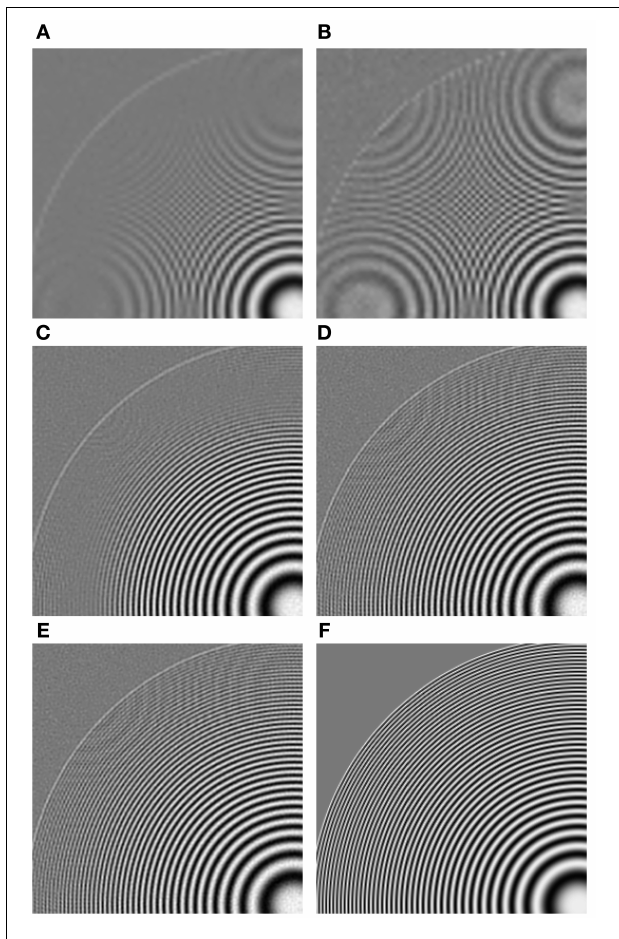
FIGURE 22 | AWF SR results for the 8 bit motocross image (kodim05.png) using simulated MWIR system with Q = 0 . 50 from Table 1 with K = 16 frames and L = 4 . (A) Bicubic interpolation of a single frame with 100% fill factor detectors ( a = 30 μ m); (B) bicubic interpolation of